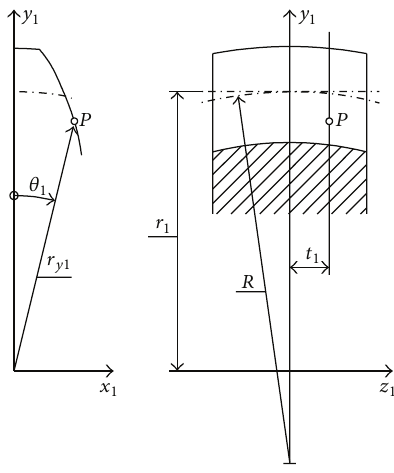
Figure 3: Crowned tooth